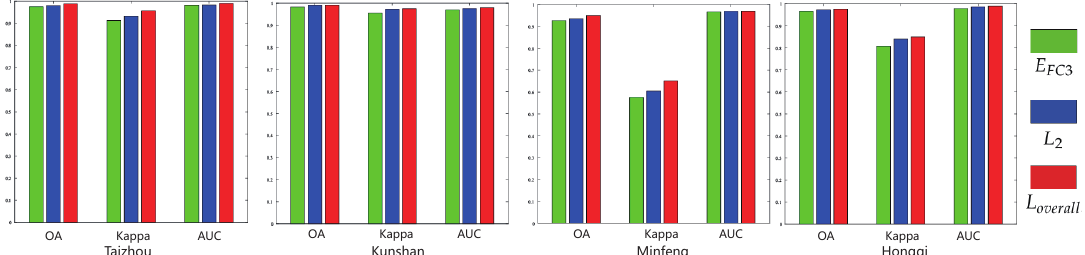
Figure 7. OA, Kappa and AUC values comparision of four different data sets. Green, blue and red colors denote E FC 3 , L 2 and L overall , respectively.